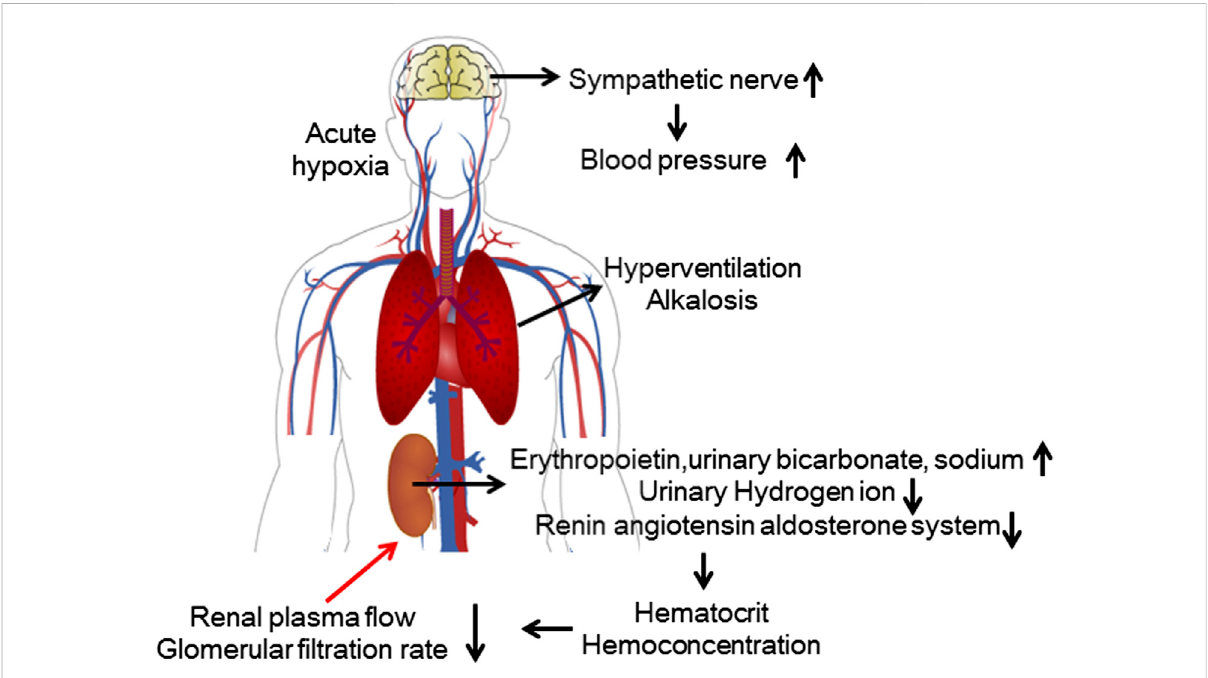
FIGURE 1 Renal physiological response to acute high-altitude exposure. During acute exposure to hypoxic conditions, activation of the sympathetic nervous system causes elevated blood pressure. The kidneys compensate for hyperventilation-induced alkalosis by regulating electrolyte metabolism. Thecompensatoryincreaseinredbloodcellsleadstoarelativedecreaseinrenalblood fl ow,andthesuppressionofRAASactivityleads to a decrease in the